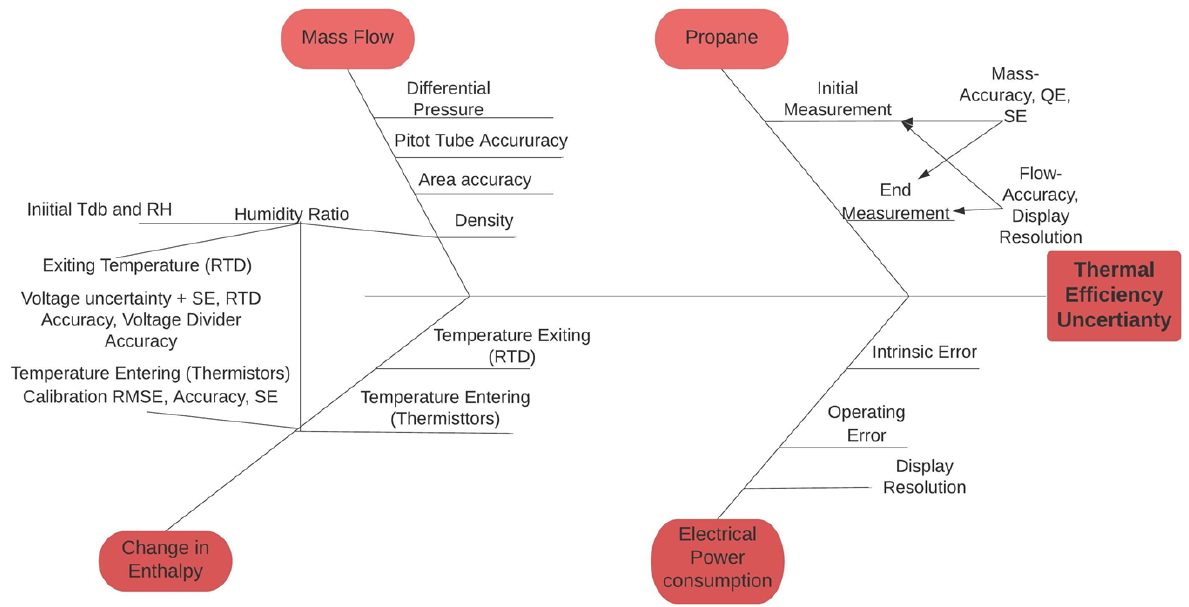
Figure 3. Fishbone diagram of the final standard uncertainty in the thermal efficiency calculation. Each line represents the integration of a measurement and its respective uncertainty into a standard uncertainty calculation.